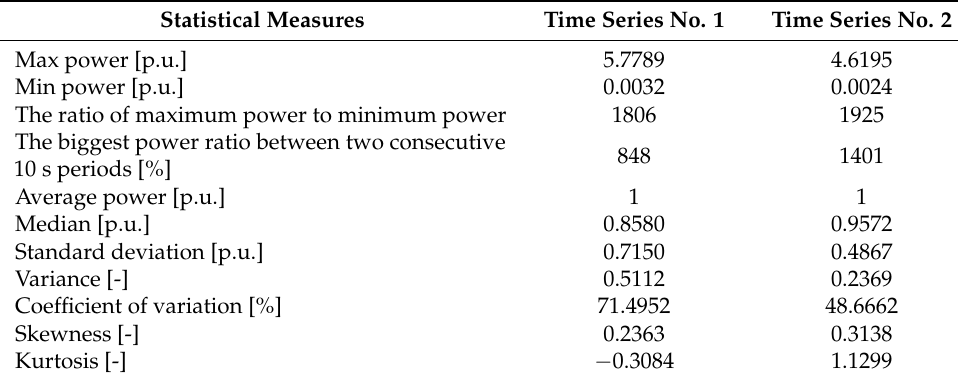
Table 1. Statistical measures of the two time series of the power demand in the technological parts of the sewage treatment